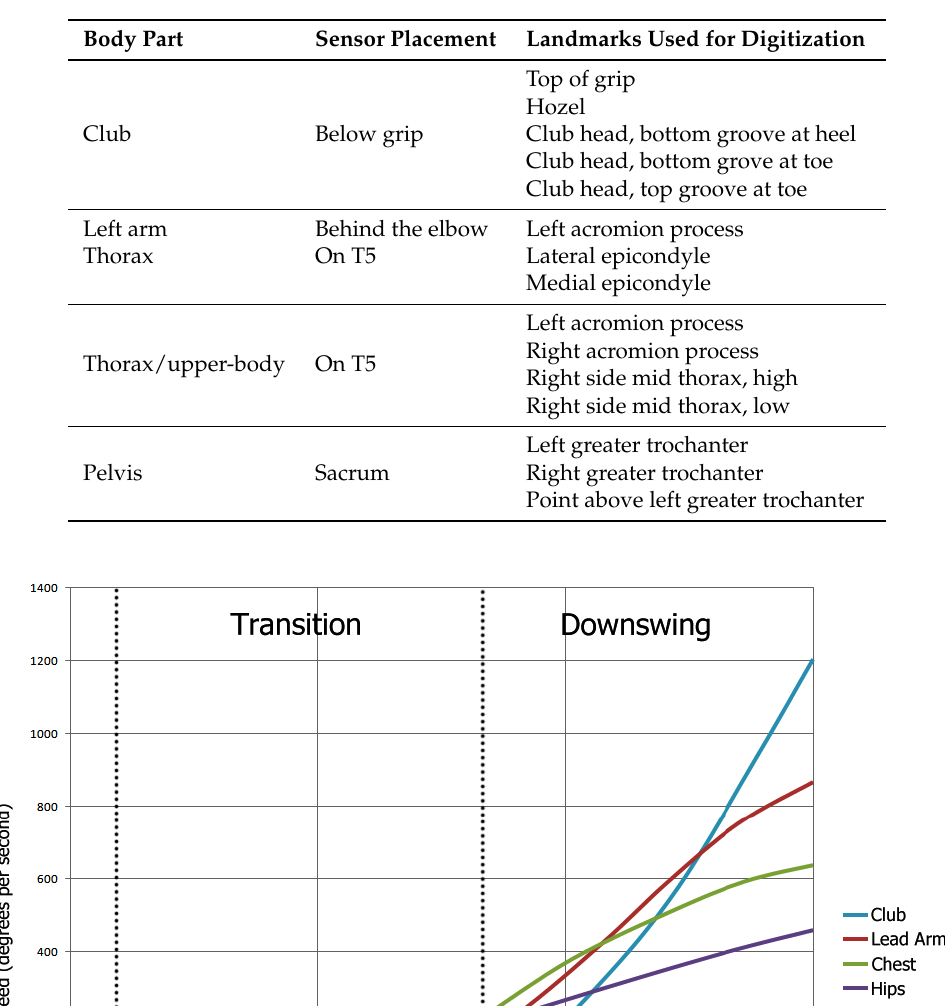
Table A1. Sensor and landmark positions.